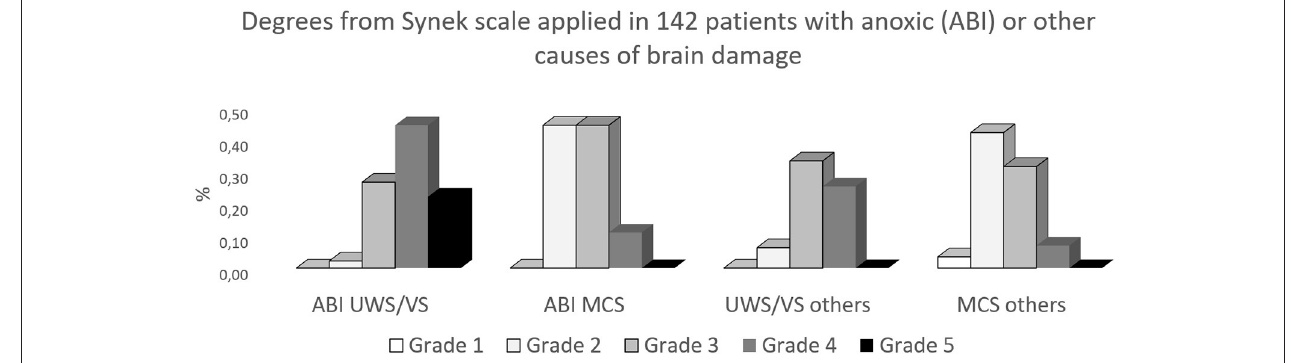
FIGURE 1 | Results from the attempt to apply the Synek scale (8) on resting EEG, obtained from 142 patients with chronic DOC. ABI, anoxic brain damage; others, traumatic or vascular brain damage; (UWS/VS), unresponsive wakefulness syndrome/vegetative state; MCS, minimally conscious